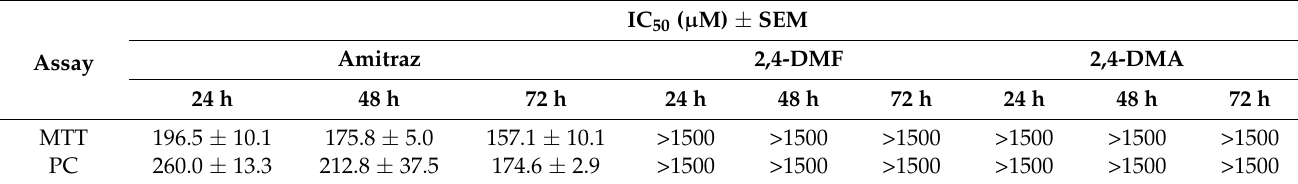
Table 1. The medium inhibitory concentration (IC 50 ) of amitraz, 2,4-DMF, and 2,4-DMA in HepG2 cells determined after 24, 48, and 72 h of incubation by the MTT and PC assays. Results are mean ± SEM (n = 3). The IC 50 values were calculated using SigmaPlot version 11 (Systat Software Inc., GmbH, Erkrath, Germany).